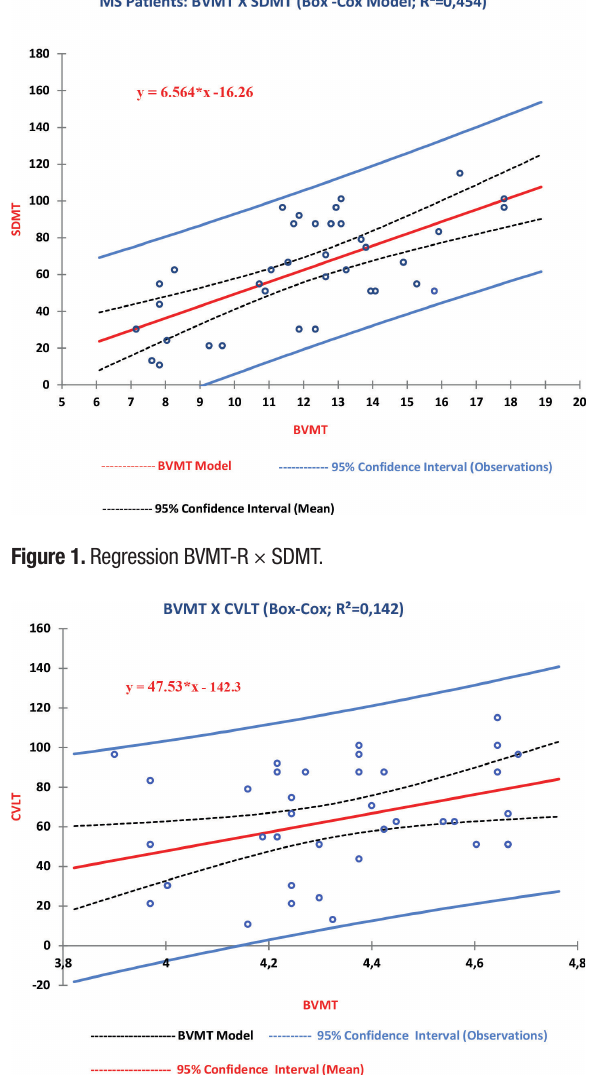
Figure 2. Regression BVMT-R × CVLT.